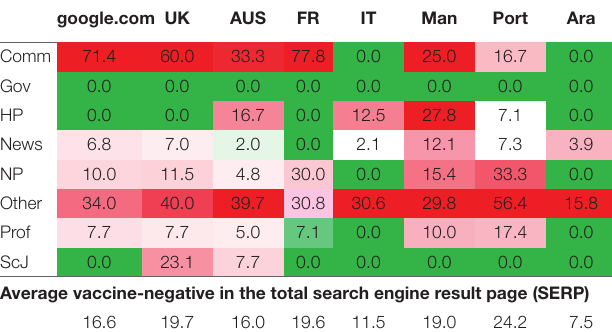
TABLE 6 | Frequency of vaccine-negative webpages in each typology. google.com UK